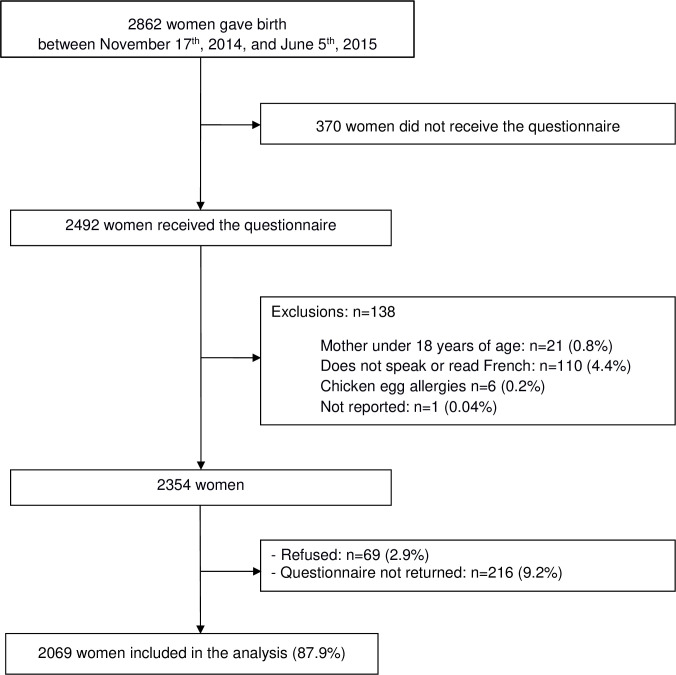
Study flow chart.